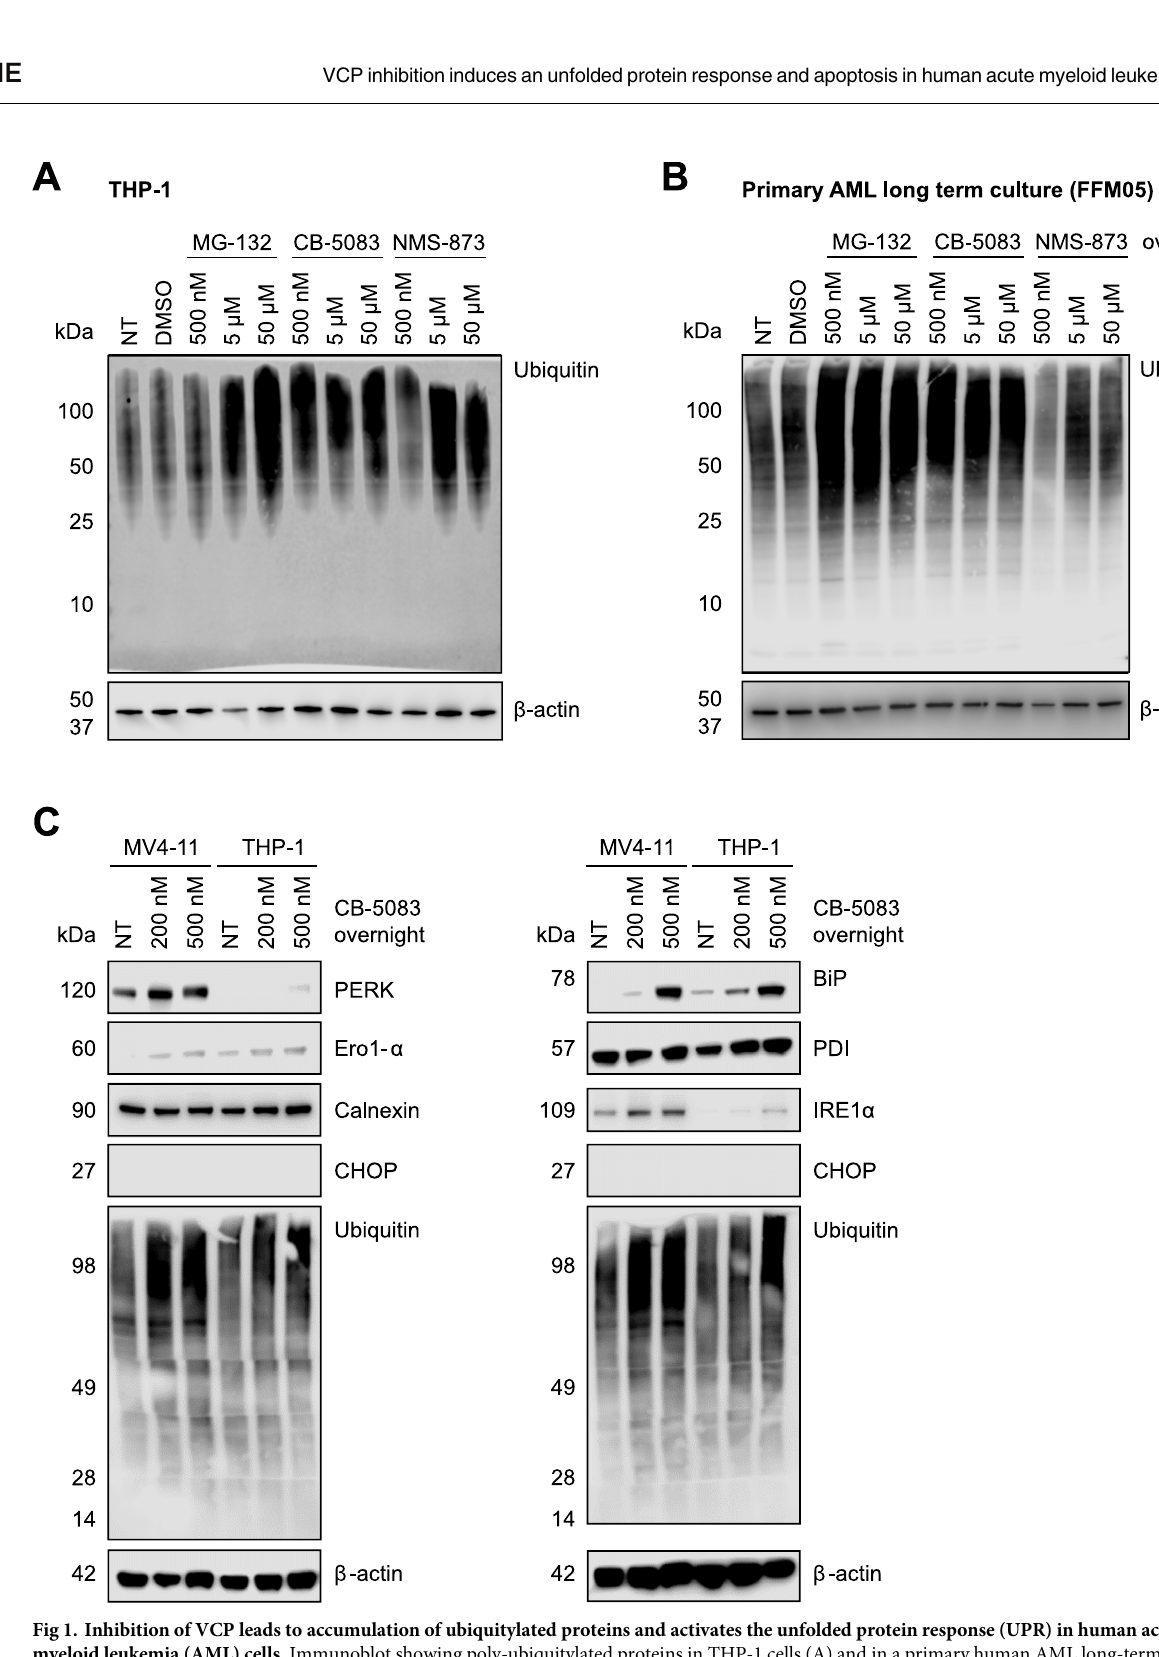
PLOS ONE | https://doi.org/10.1371/journal.pone.0266478 April 6,